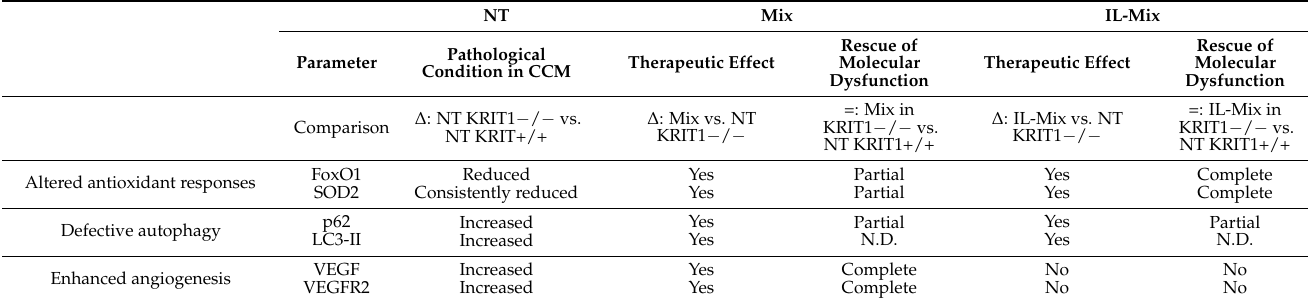
Table 2. Effects of Mix and IL-Mix on the main CCM molecular phenotypes. Abbreviations: